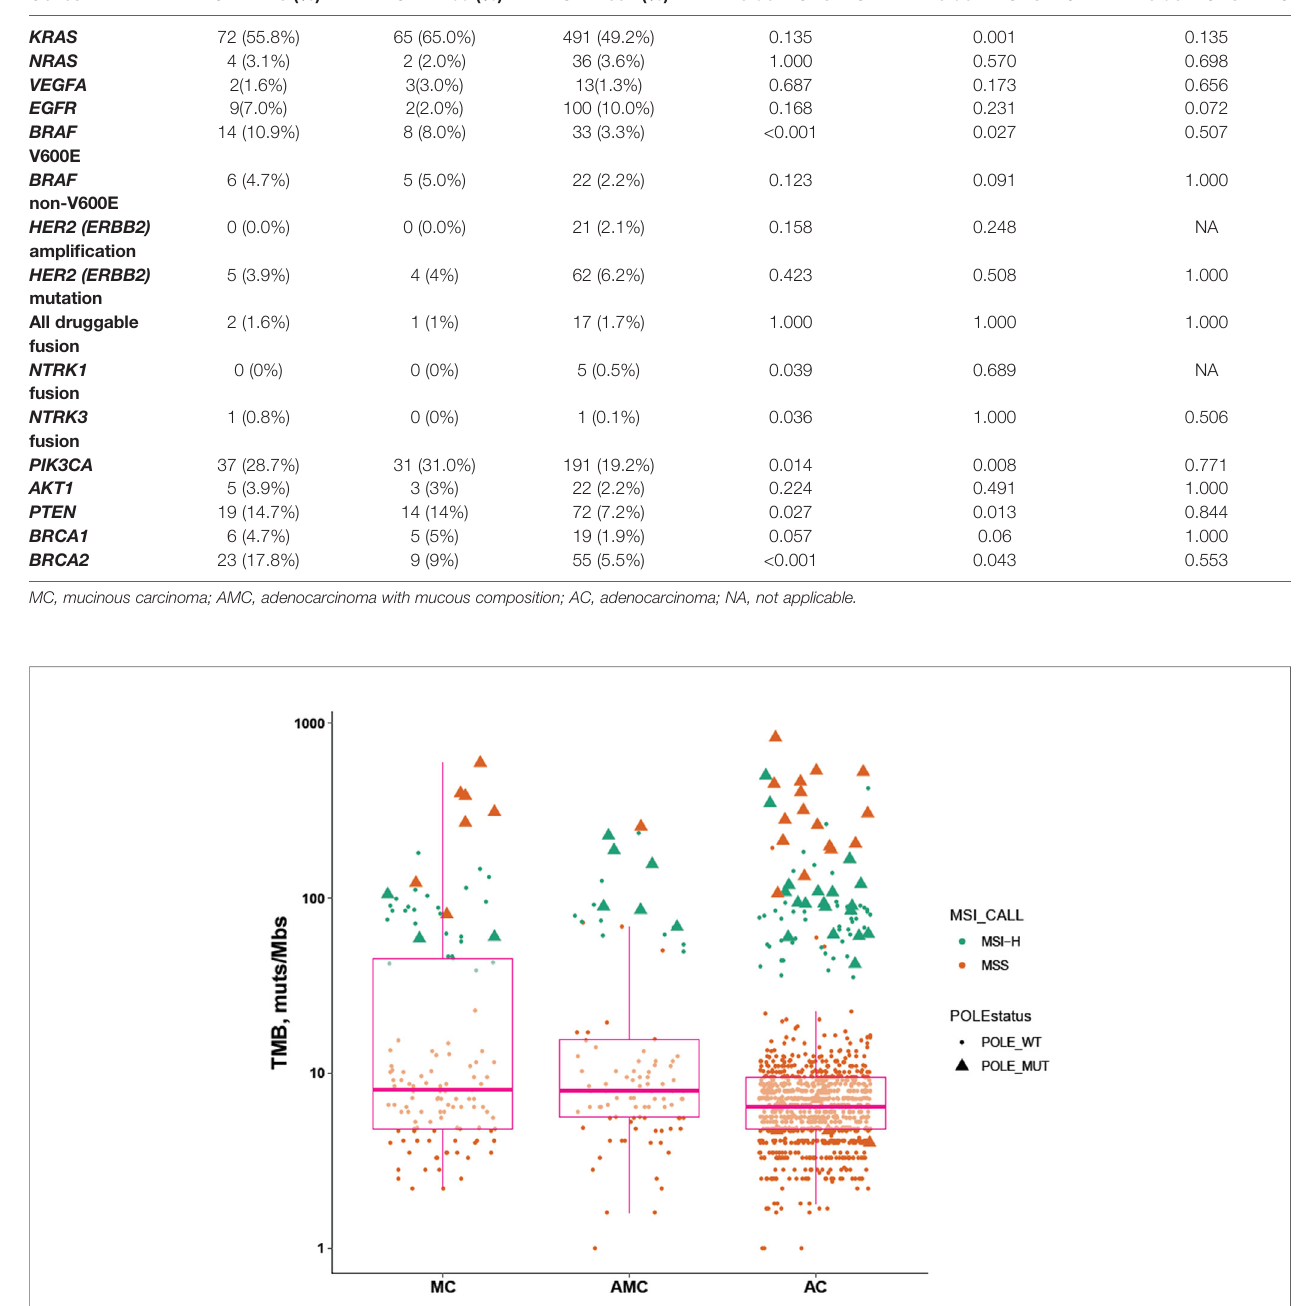
FIGURE 3 | Comparison of immunotherapy-related biomarkers in MC, AMC, and AC. MC, mucinous carcinoma; AMC, adenocarcinoma with mucous composition; AC, adenocarcinoma; MSI, microsatellite instability; TMB, tumor mutational burden; MSS, microsatellite